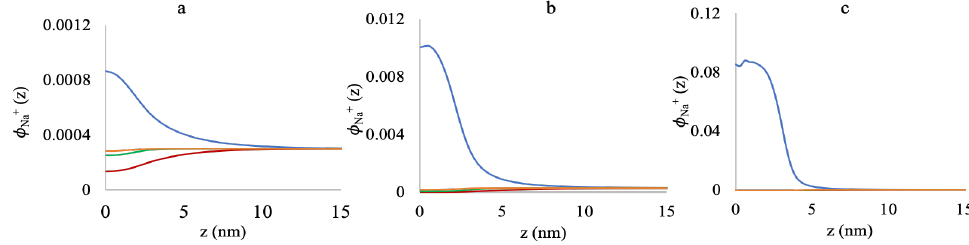
Figure 10. Volume fraction profiles of free Na + ions as a function of distance from the grafting surface in the presence of 10 mM NaCl salt and at ( a ) 0.005 chains/nm 2 , ( b ) 0.05 chains/nm 2 , and ( c ) 0.5 chains/nm 2 grafting densities for 0 mM (blue lines), 3 mM (red lines) 50 mM (green lines), and 180 mM (yellow lines) MgCl 2 salt concentrations. Note the different scales of the plots